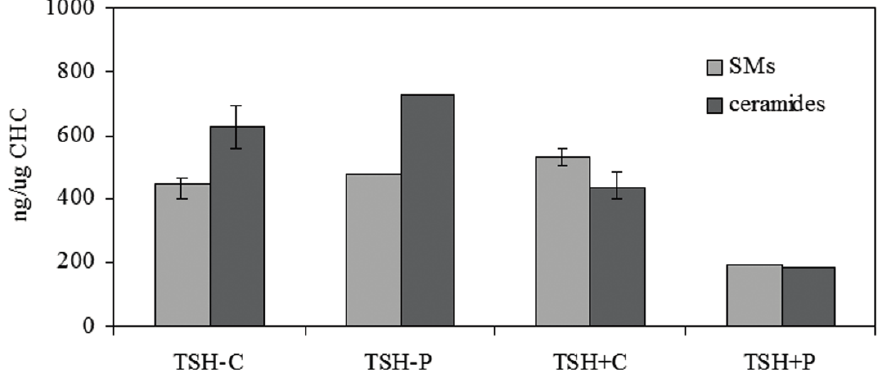
Figure 4. Effect of proton irradiation on total sphingomyelin (SM) and ceramide species under study of nuclei-free lysates (NFL) and purified nuclei (N) prepared from quiescent (TSH − ) and proliferating (TSH+) cells. C, control; P, proton. Data are expressed as μ g/ μ g cholesterol (CHO) and are expressed as mean and range of three separated experiments for C samples. Results of P samples are only of one experiment.